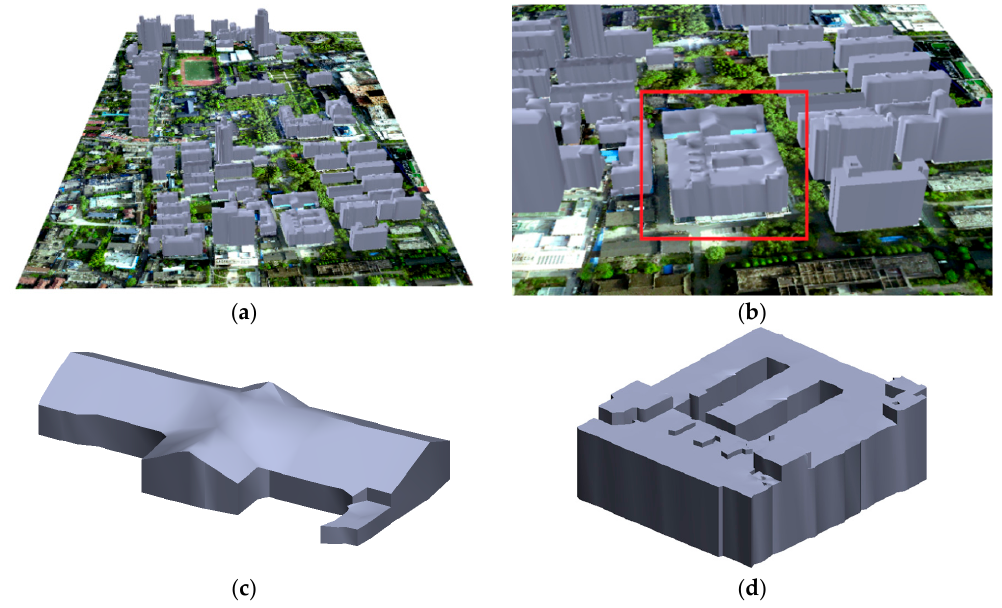
Figure 8. Reconstruction results in Region 1: ( a ) an overview; ( b ) a side view of the local reconstructed roof models; and ( c ) and ( d ), building roof models for the red box in ( b ).